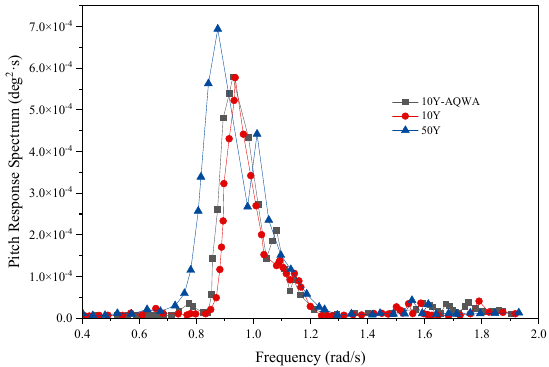
Figure 10. Surge response spectrum.